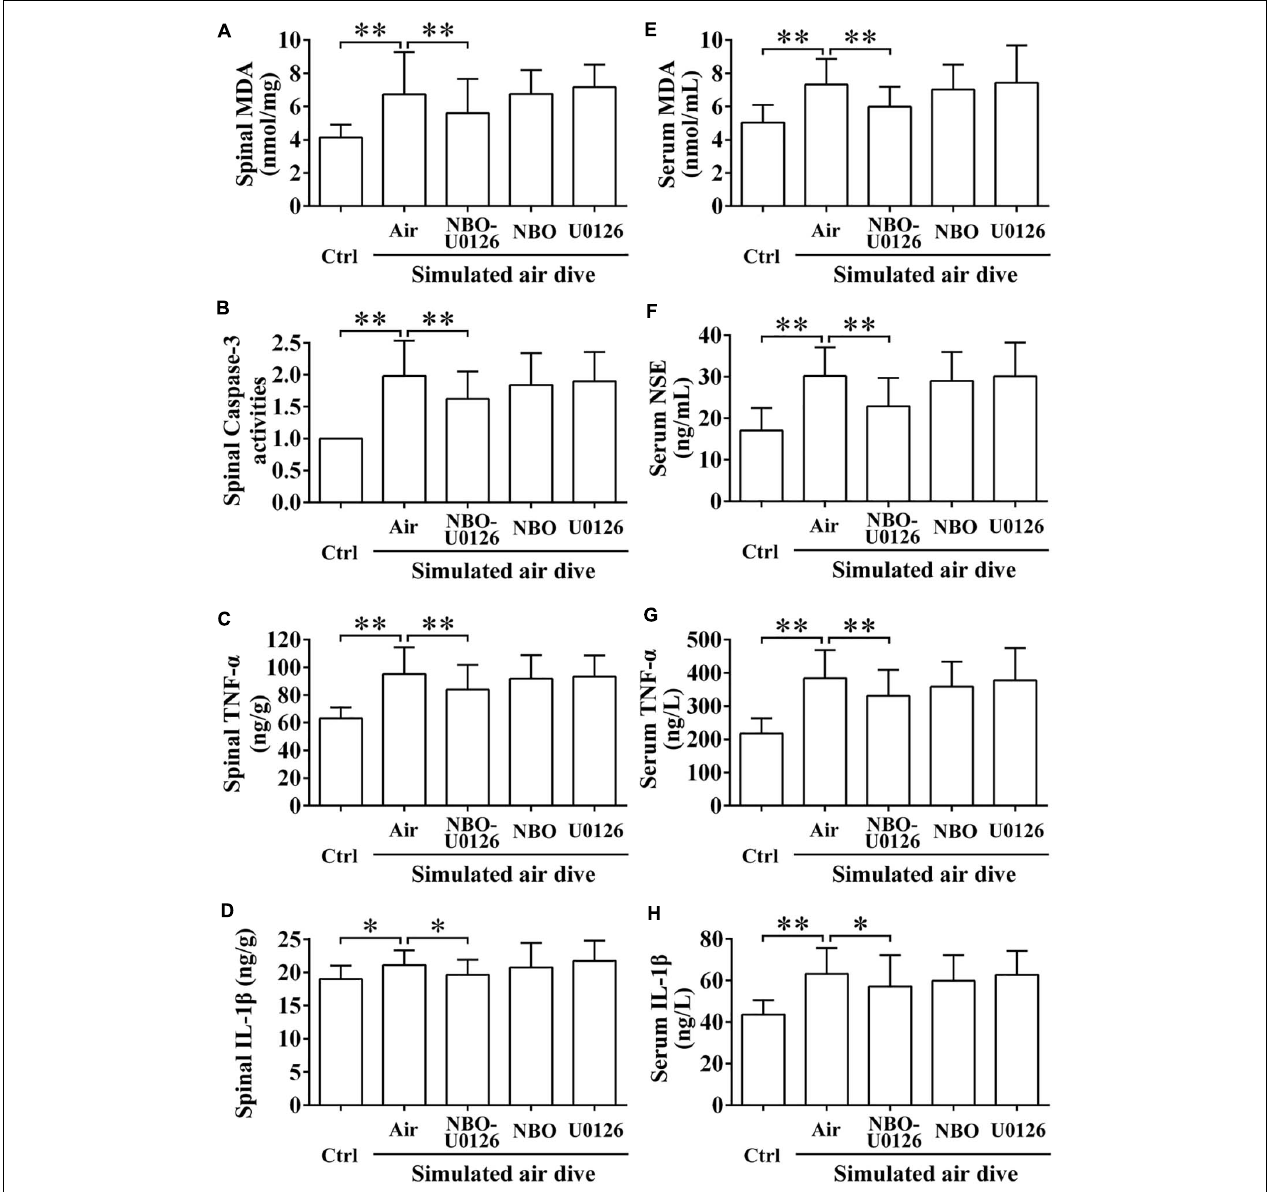
FIGURE 5 | Effects of NBO-U0126 on spinal cord and serum biomarkers after simulated air dive. Spinal cord and serum biomarkers were measured in all surviving rats 2 h after simulated air dive (Ctrl n = 12, Air n = 30, NBO-U0126 n = 31, NBO n = 29, U0126 n = 30). (A–D) Spinal cord biomarkers; (E–H) Serum biomarkers. ∗ P < 0.05, ∗∗ P <